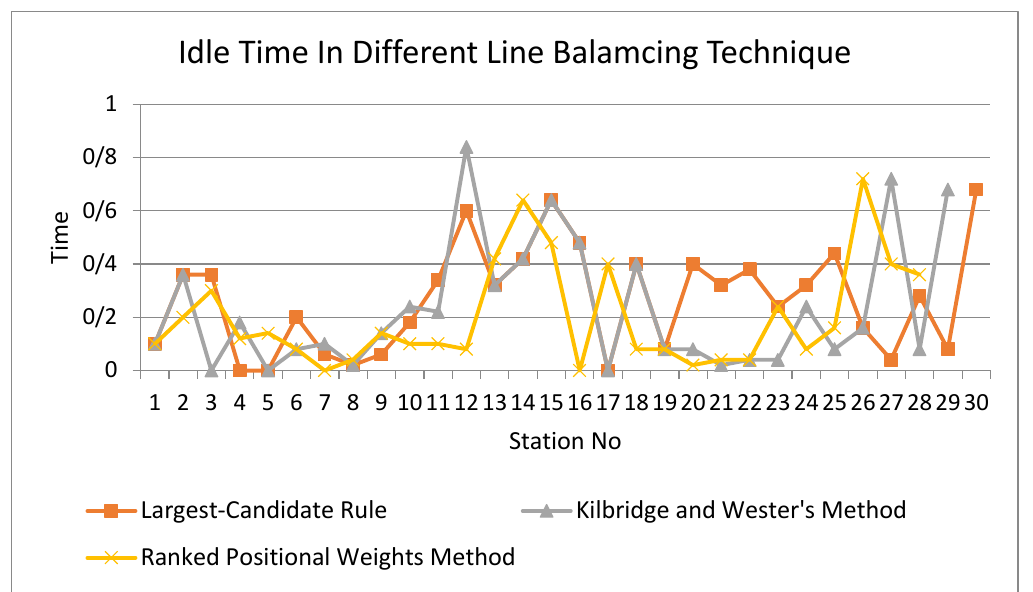
Figure 13. Comparison of idle time at different stations in different